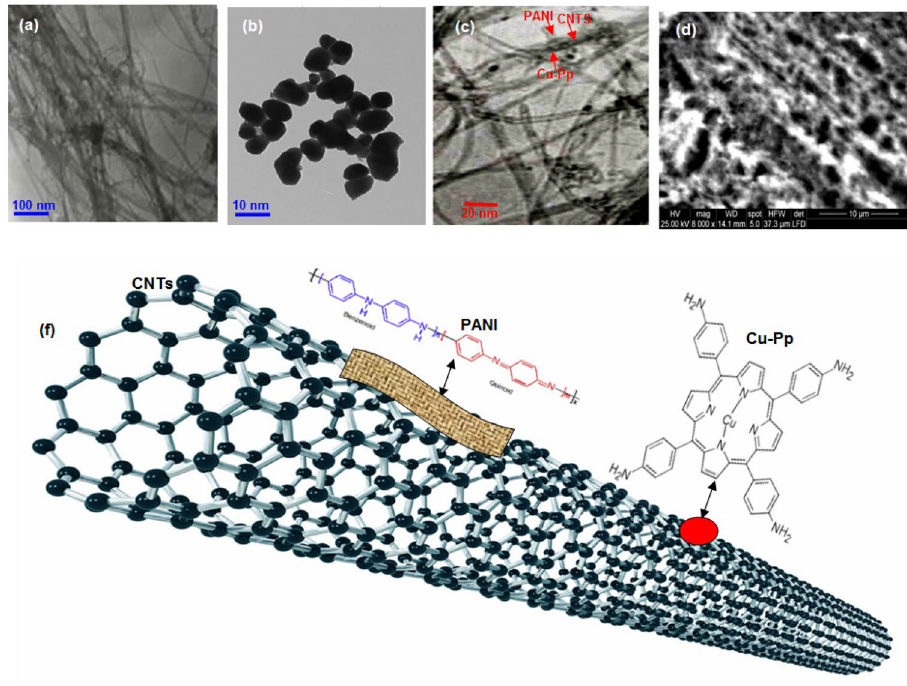
Figure 1. ( a ) TEM image of CNTs, ( b ) TEM image of Cu-Pp, ( c ) TEM image of PANI/Cu-Pp/CNTs composite, ( d ) SEM image of PANI/Cu-Pp/CNTs composite, and ( f ) The illustration of PANI/Cu-Pp/CNTs composite.